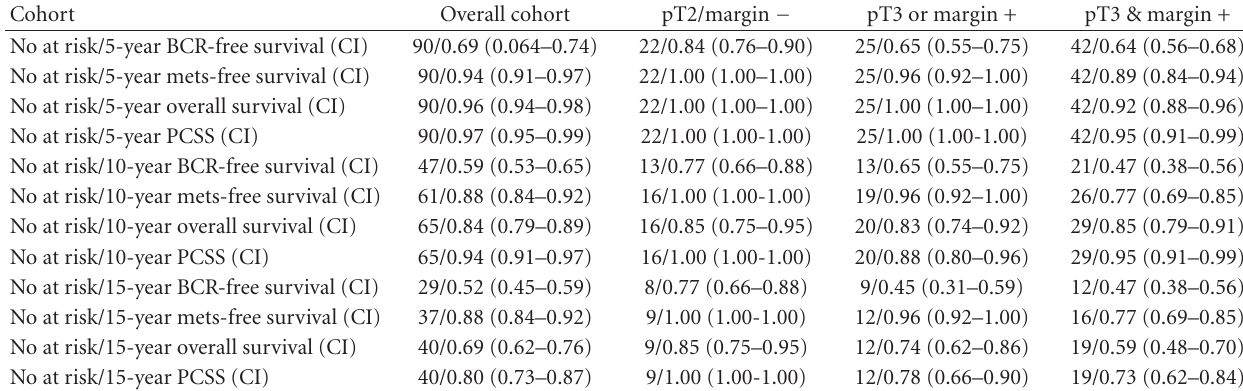
Table 3: Kaplan-Meier actuarial estimates of BCR-free survival, metastases-free survival, overall survival, and prostate cancer specific survival